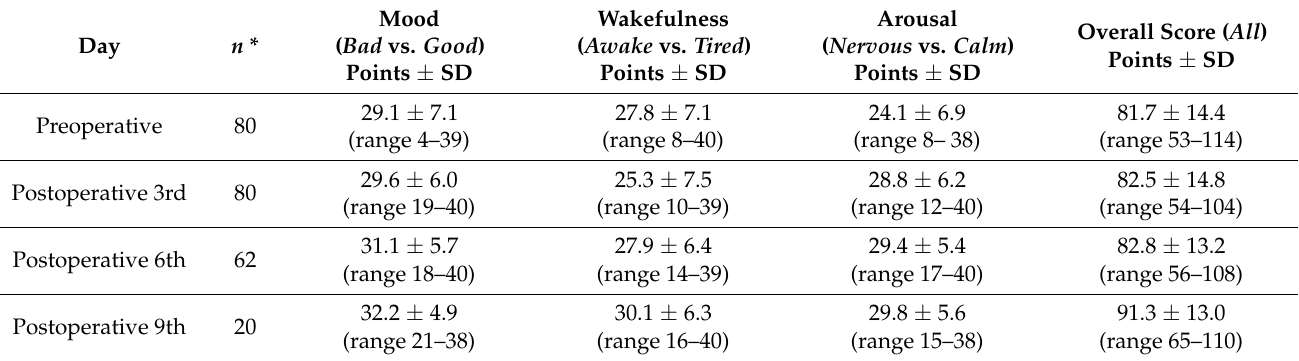
Table 2. Results of multi-dimensional questionnaire (MDMQ) preoperatively as well as on the 3rd,